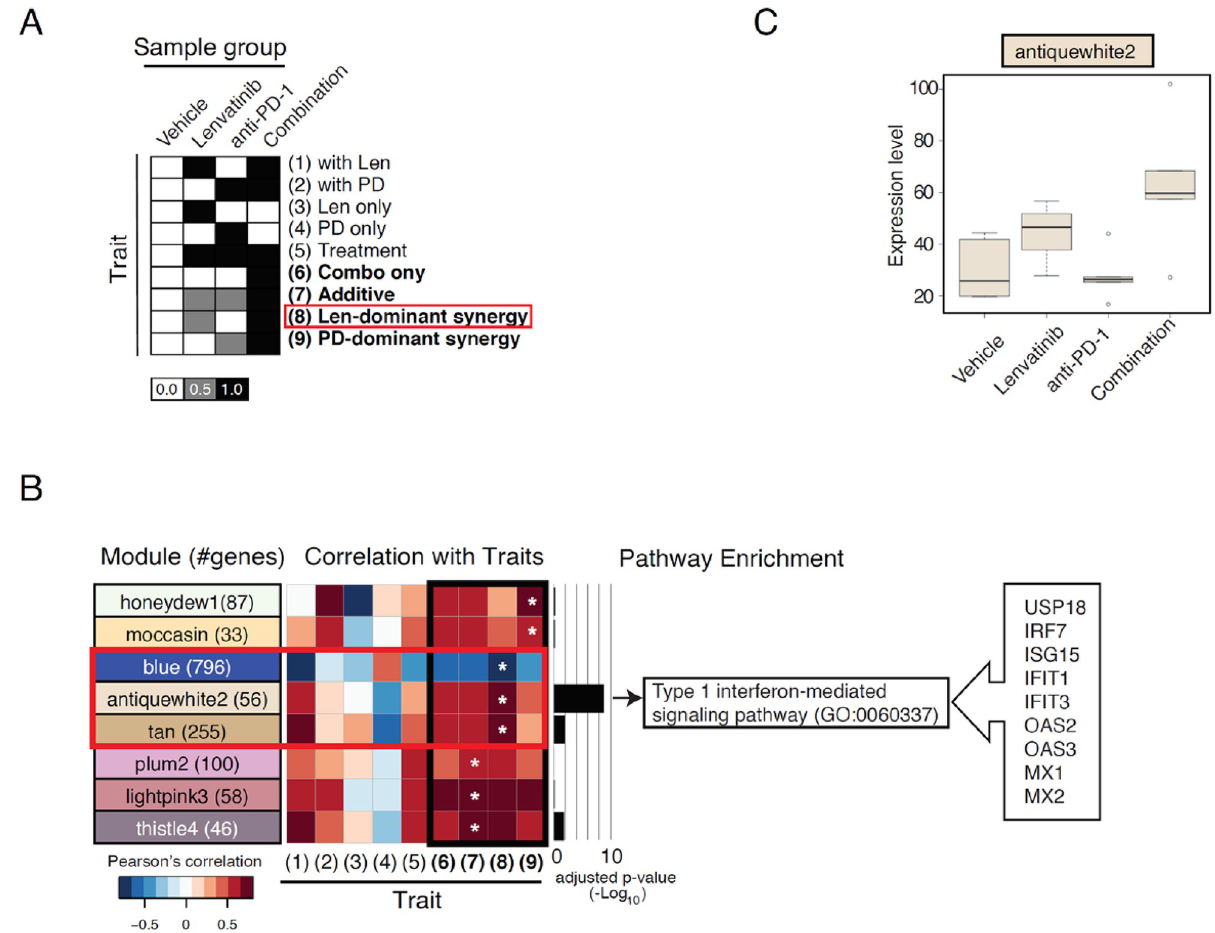
Fig 5. Weighted gene co-expression network analysis (WGCNA) to identify gene subsets modulated by combination treatment. RNA-Seq analysis of tumor tissues followed by WGCNA was performed by using CT26 tumor tissues. A. Defined sample traits, each of which reflects a pattern of expression as indicated in the text. Gene subsets that correlate with one of traits (6) through (9) are considered to be possible target gene sets of the ‘potentiating effect’ of the two drugs. B. Modules from the WGCNA selected for trait correlation analysis. The modules highly correlated with one of the modules in A (r > 0.65 and P < 0.01) are shown with the number of genes included in each module in parentheses. The correlation strength of each module with each trait is shown in the heatmap where the most highly correlated trait is indicated by an asterisk. The significance (FDR-adjusted P value) of the top over-represented pathway in each module is shown in the bar graph, and the significantly enriched pathway is indicated (FDR- adjusted P value < 0.05). The genes in the antiquewhite2 module represented in the type-I IFN signaling pathway are shown in the arrow box to the right. C. Eigengene expression pattern for the antiquewhite2